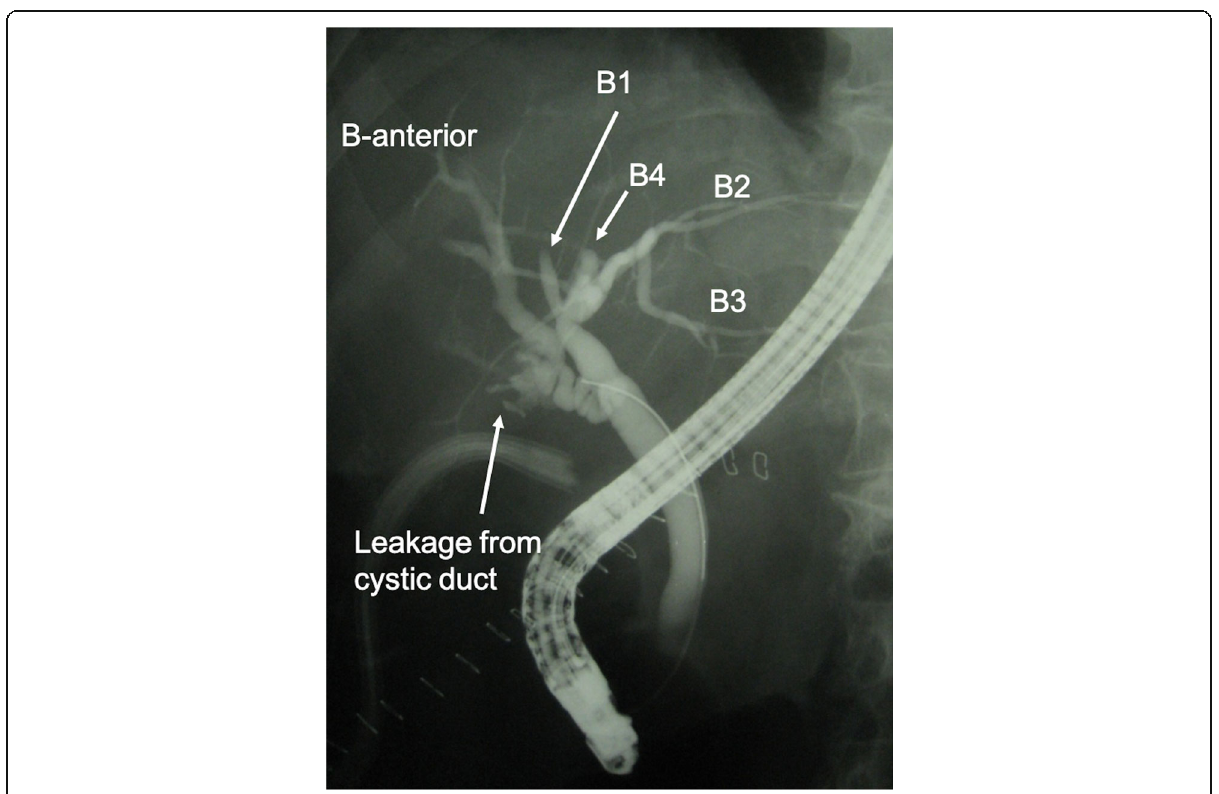
Fig. 3 Postoperative cholangiography by endoscopic retrograde cholangiopancreatography revealed the main right hepatic duct entering the cystic duct and bile leakage from the stump of the gallbladder neck